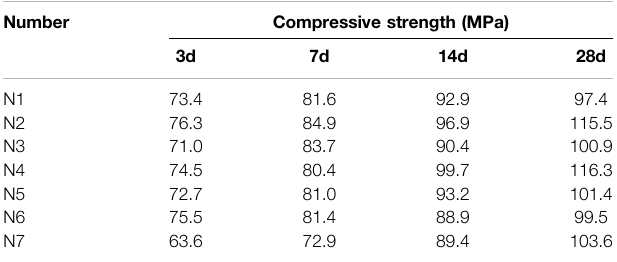
TABLE 5 | Compressive strength of UHPC (M-PCE).